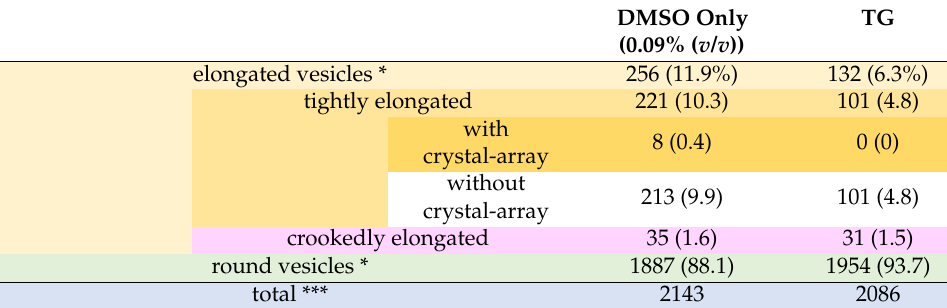
334 335 336 337